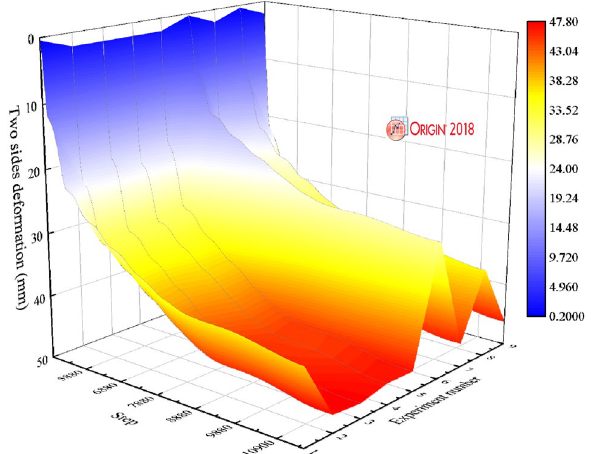
Figure 6. Deformation law of two sides under different support schemes.